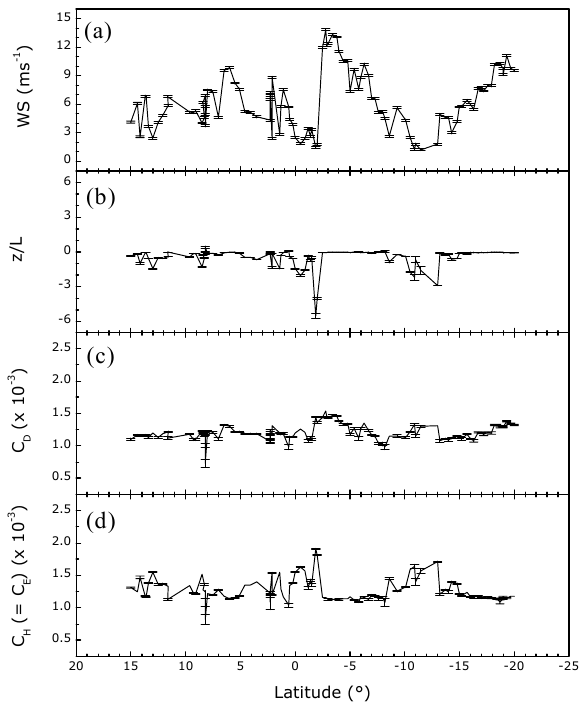
Fig. 3. Latitudinal variation of air-sea interaction parameters along cruise leg-1. (a) Wind Speed ( WS ,ms − 1 ); (b) Stability Parameter ( z/L ); (c) Drag Coefficient ( C D , × 10 − 3 ); (d) Sensible Heat and Water Vapour exchange coefficients ( C H and C E , × 10 − 3